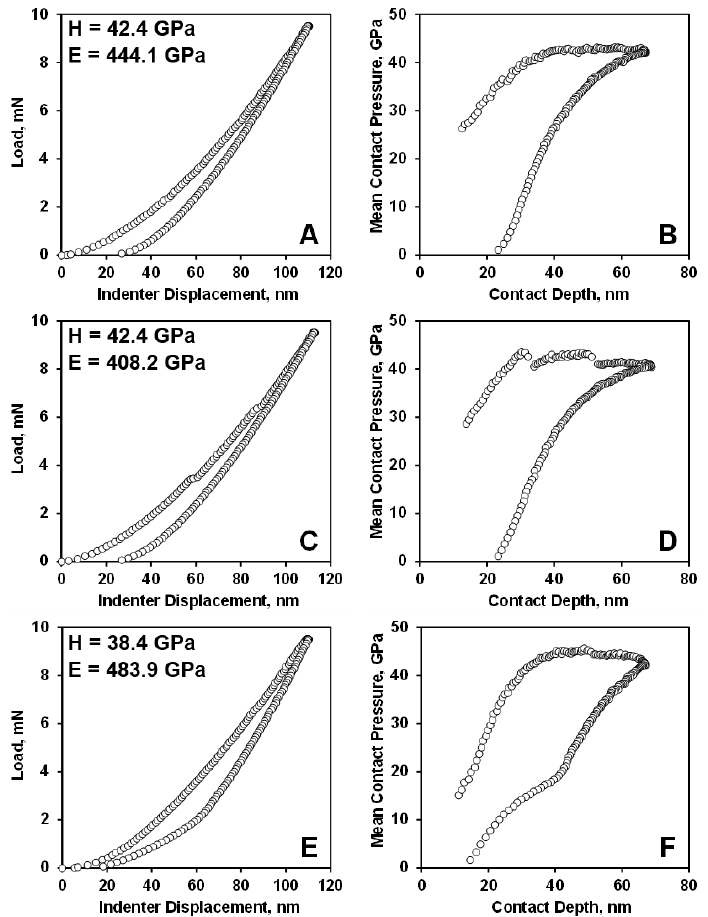
Figure 7. Nanoindentation load-displacement curves ( A , C , E ) and mean contact pressure-contact depths ( B , D , F ) for B 4 C for loading and unloading indentation behavior. Upon further loading, the mean contact pressure recovered back to above 40 GPa, where a second pop-in event was detected at a contact penetration depth of about 50 nm. The appearance of such pop-in events during loading of B 4 C can possibly be explained either by plastic deformation by nucleation of dislocations [55] or a high pressure structural phase transition, with an associated decrease in the volume of the high-pressure phase [99,101]. The simulated estimate of ~4% sudden volume reduction were reported in [102], however, the pressure where such a significant volume change would occur was estimated to be ~22.8 GPa. Structural recovery and formation of disordered phases were reported to occur in a number of materials upon unloading [103]. The discontinuities and changes in the slopes upon unloading of B 4 C were reported in [56]. In our nanoindentation